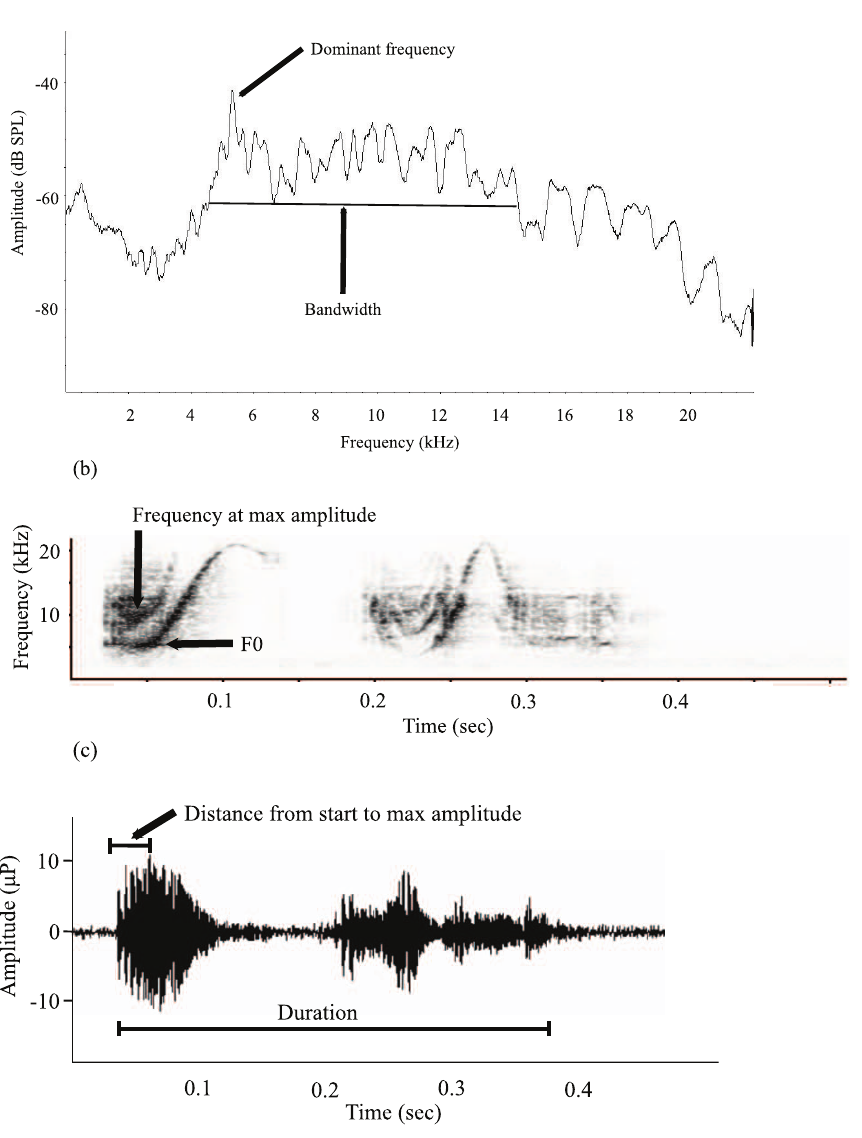
Figure 1. Acoustic parameters of rock hyrax pup screams. (a) A spectrum of a scream with two sub-elements. The amplitude is shown as a function of frequency. (b) A spectrogram showing frequency as a function of time. (c) A waveform showing the amplitude as a function of time.